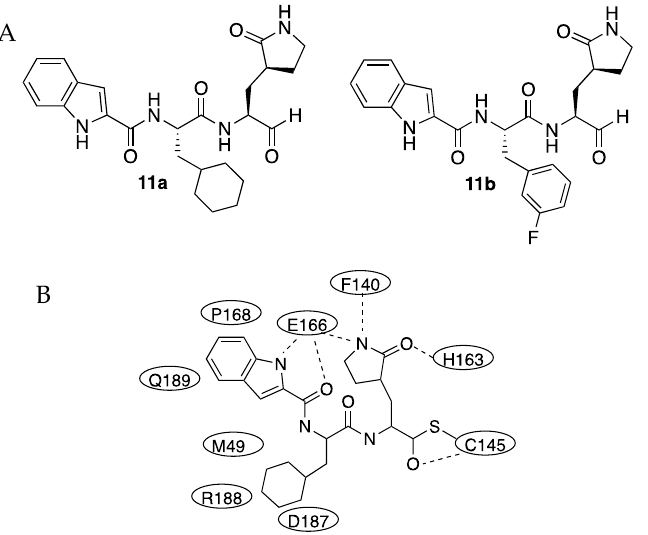
Figure 3. ( A ) Inhibitors 11a and 11b . ( B ) Scheme of the interactions in the X ‐ ray structure of inhibitor 11a with SARS ‐ CoV ‐ 2 Mpro.